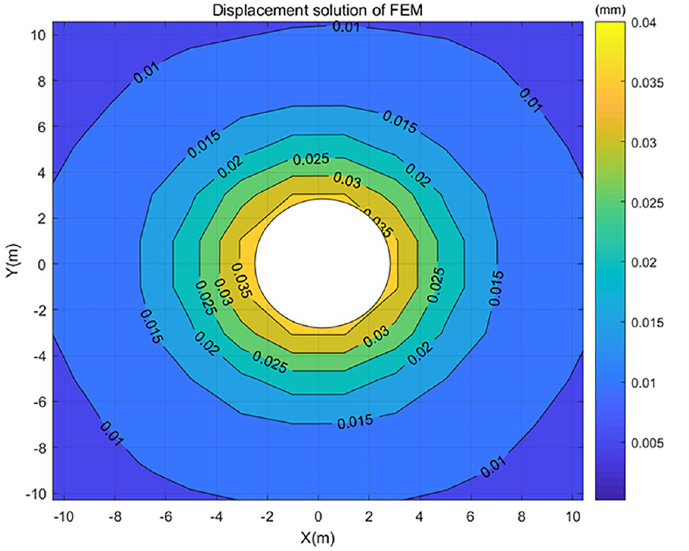
Fig 8. Displacement contour map of classical FEM within 10m center